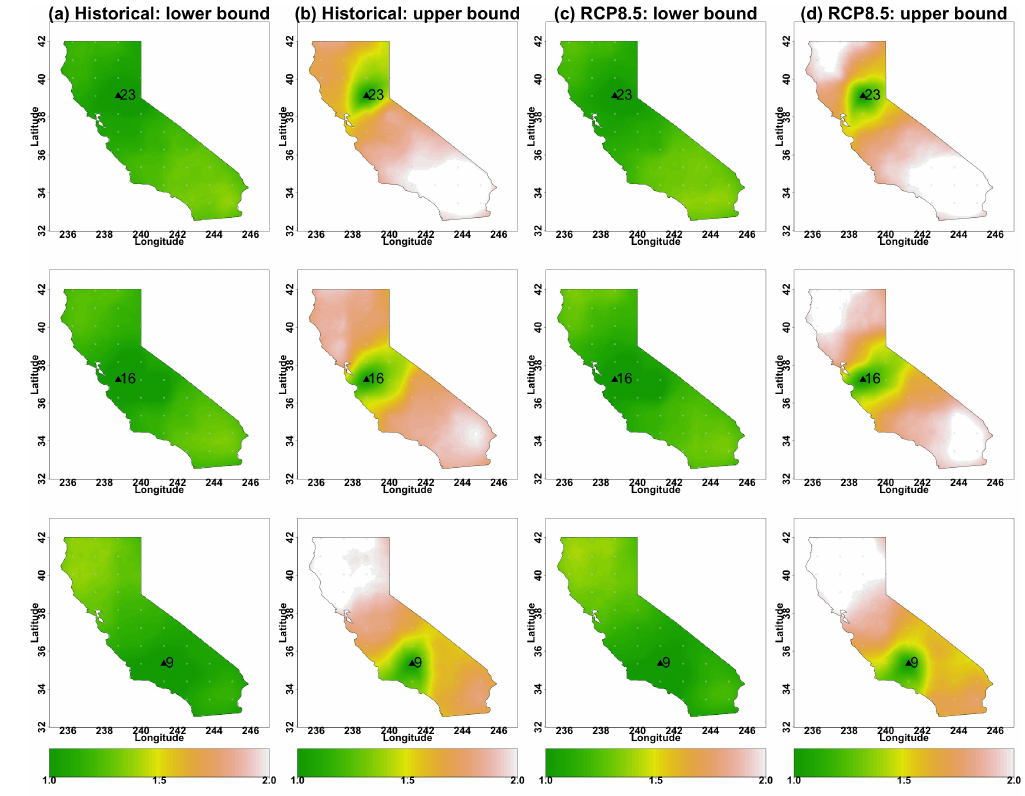
Figure 7. Lower ( (a) for historical run and (c) RCP8.5 run) and upper bounds ( (b) for historical run and (d) RCP8.5 run) of 95% confidence intervals for the ensemble means of pairwise extremal coefficients in Fig. 6 for CMIP5 multi-model ensembles. Black triangle points represent the grid locations 23, 16, and 9 from top to